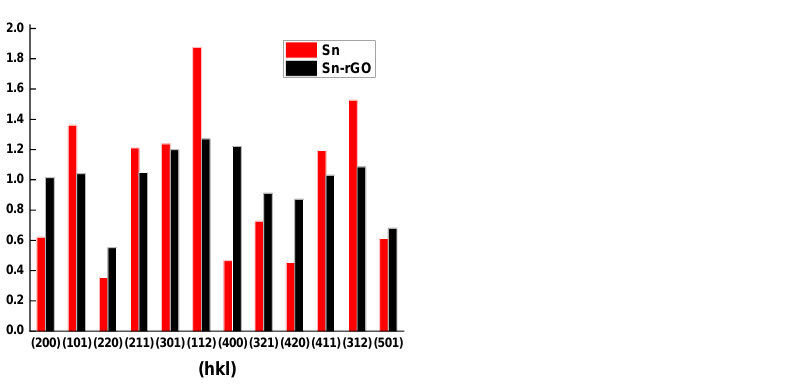
Figure 10. Texture coefficient values for different planes of Sn and Sn-rGO composite coatings calculated from XRD peak intensities (j =15 mA cm − 2 )